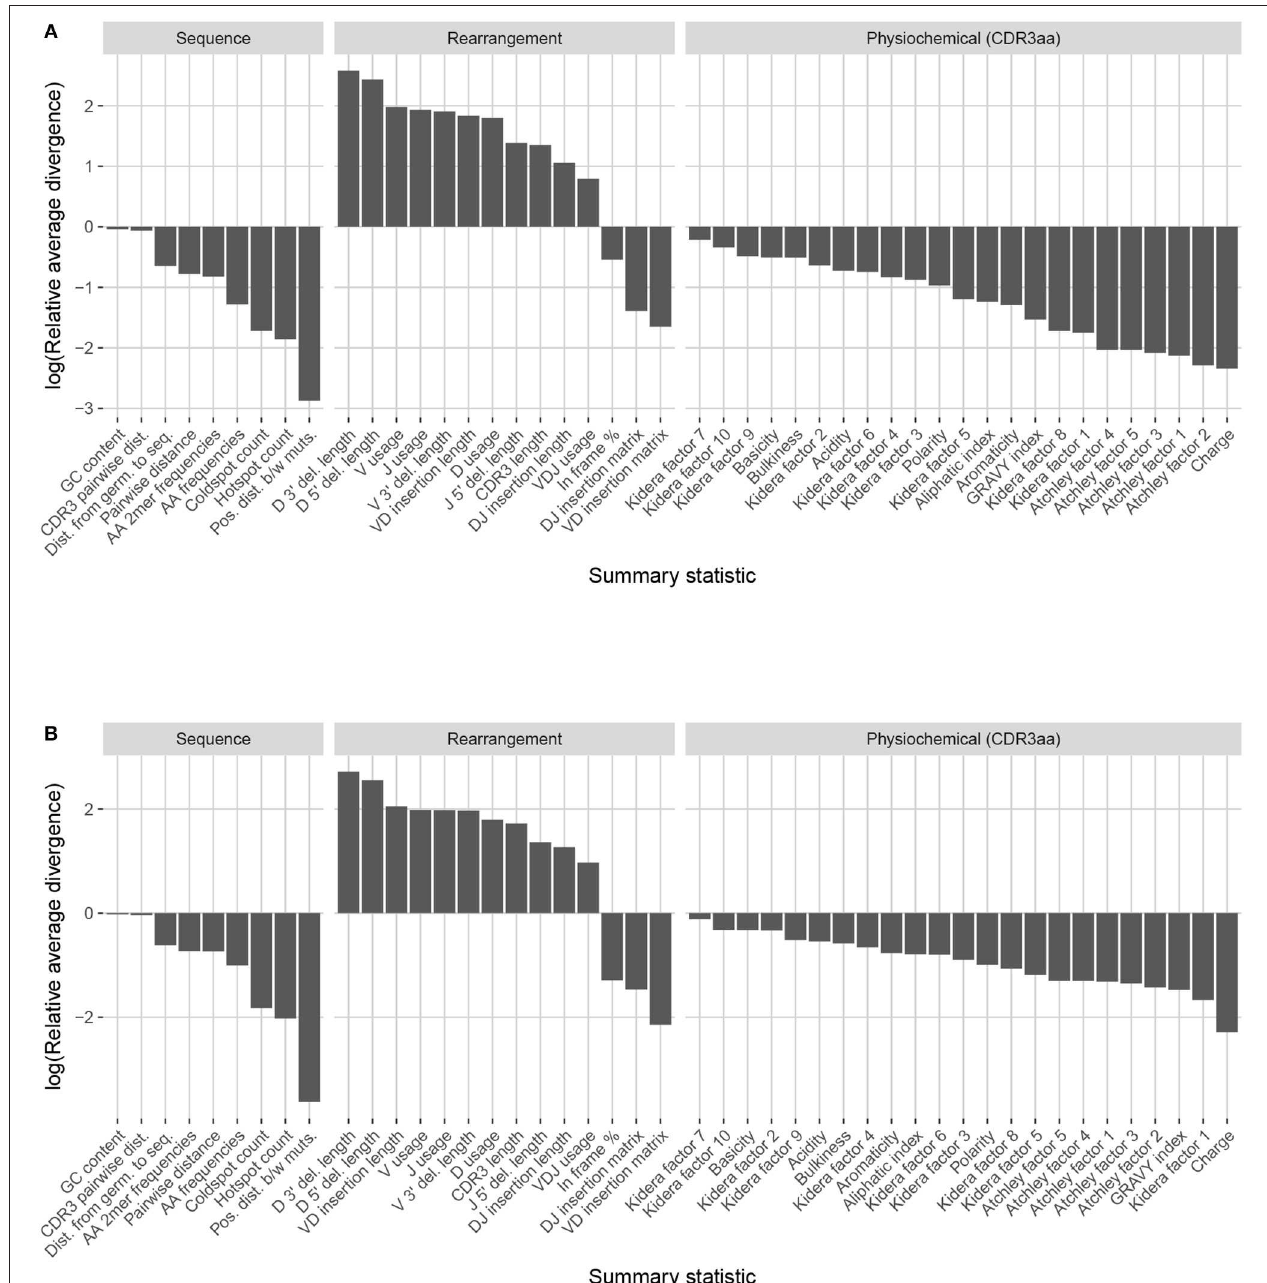
FIGURE 9 | Summary scores, denoted as “log(Relative average divergence)” or “LRAD,” for each statistic in the partis model validation experiment. For both cases, a high score indicates a well-replicated statistic by the simulations with respect to their corresponding experimental repertoires of productive IGH sequences. (A) LRAD-data values for each relevant IGH statistic available from partis as determined by Equation (8). (B) LRAD-sim values for each relevant IGH statistic available from partis as determined by Equation (9). In the case where P and Q are both discrete